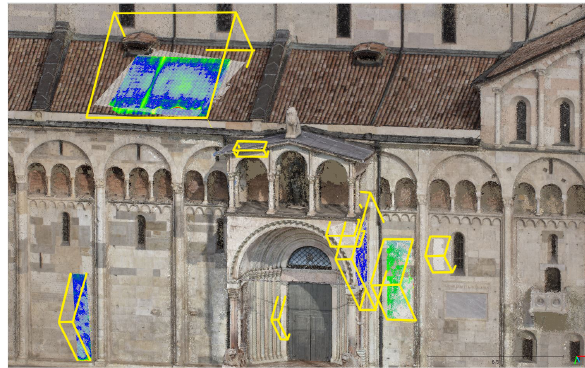
Figure 7: Some areas selected for plane fitting